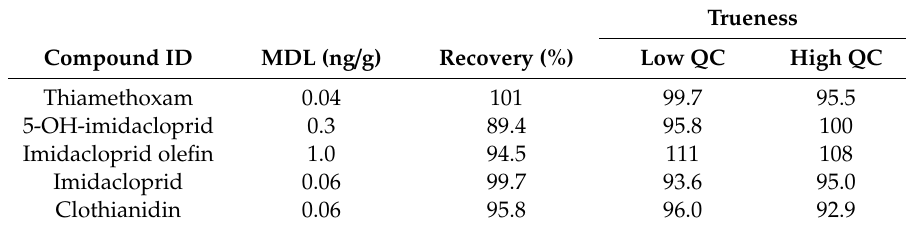
Table 3. Method detection limit (MDL), recovery, trueness, and matrix e ff ect for five target analytes in the pollen matrix